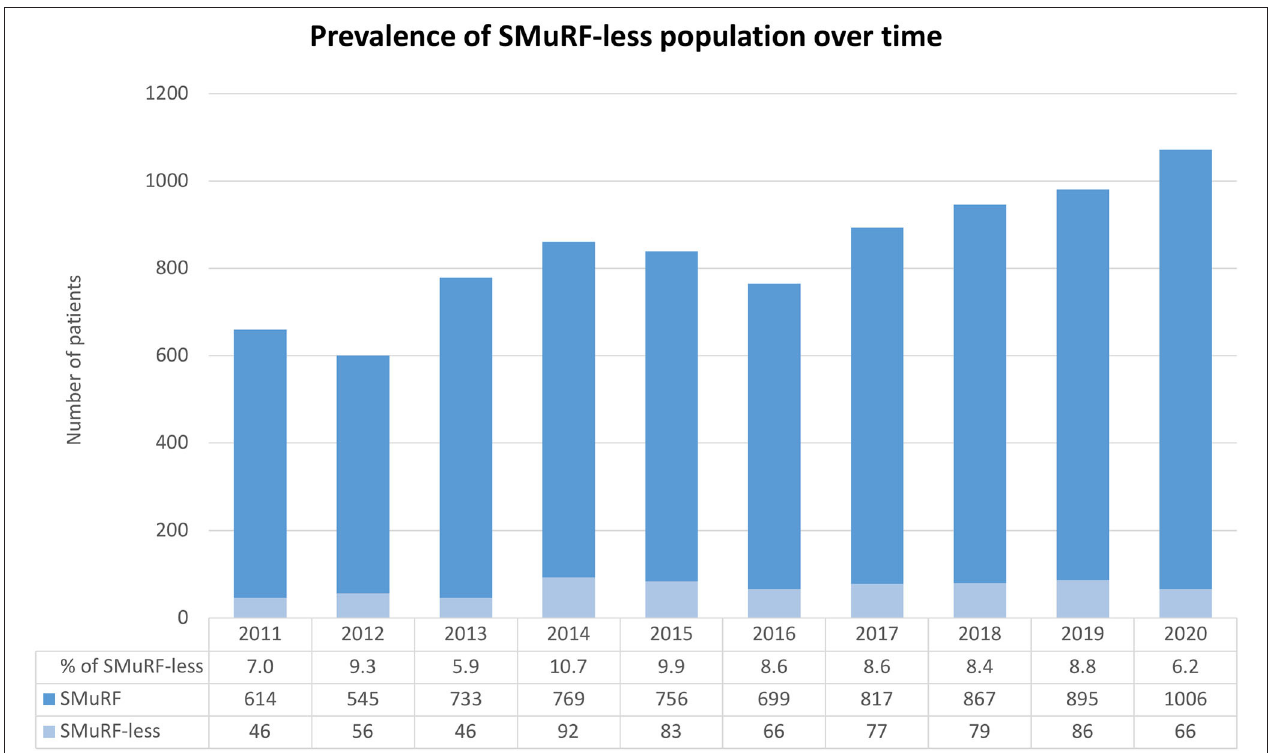
FIGURE 1 | Bar graph displaying the prevalence of the SMuRF-less population from 2011 to